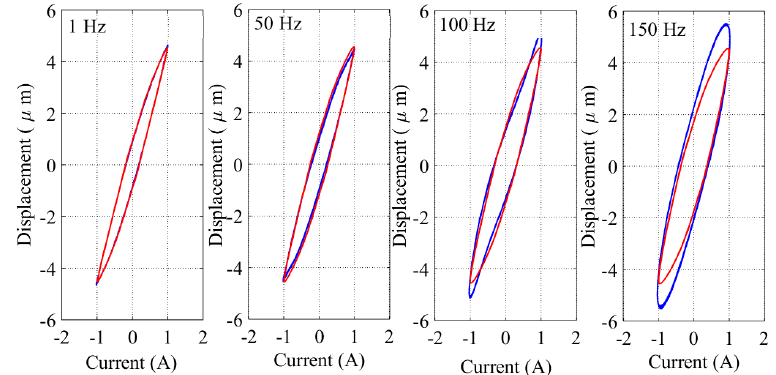
Figure 9. Comparisons of major-loop output-input responses between the proposed model and the measured data with load (4.2kg). (Fre- quencies in 1, 50, 100 and 150Hz and excitation amplitude 1A, blue line – measured data; red line – proposed model.)